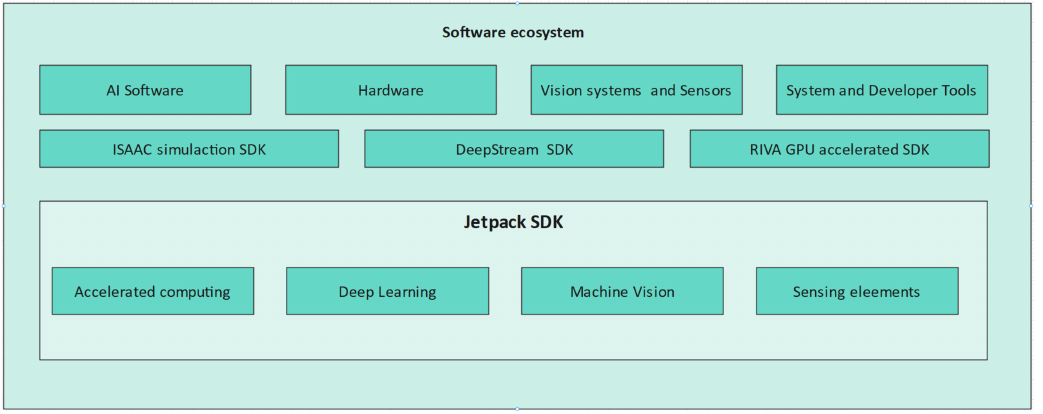
Figure 8. Jetpack Software